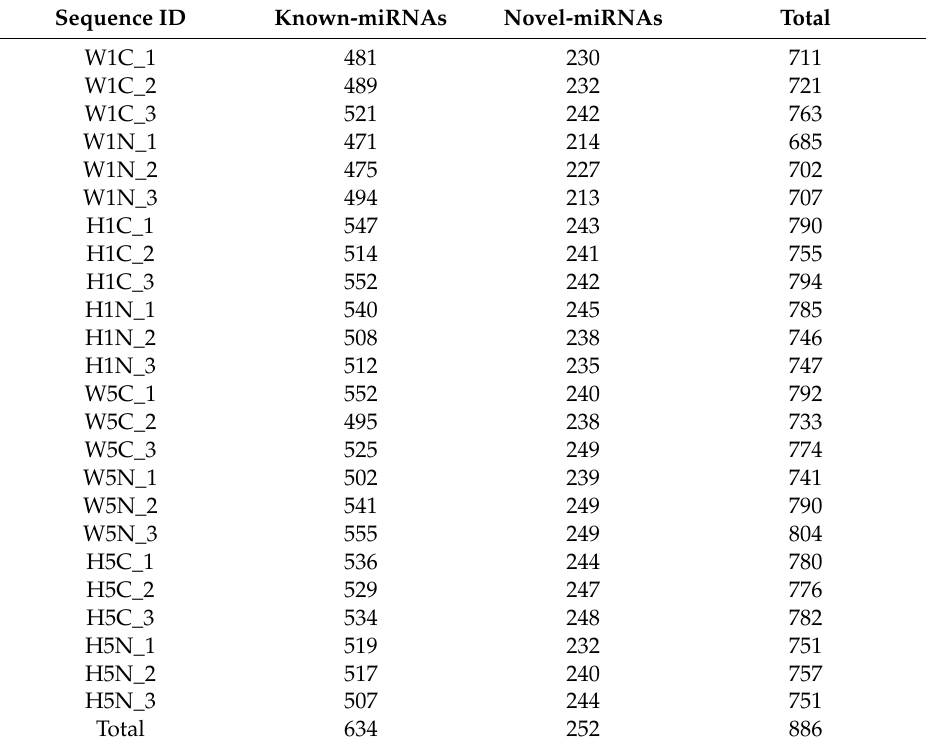
Table 2. Known miRNA identified and novel miRNA predicted in 24 small RNA